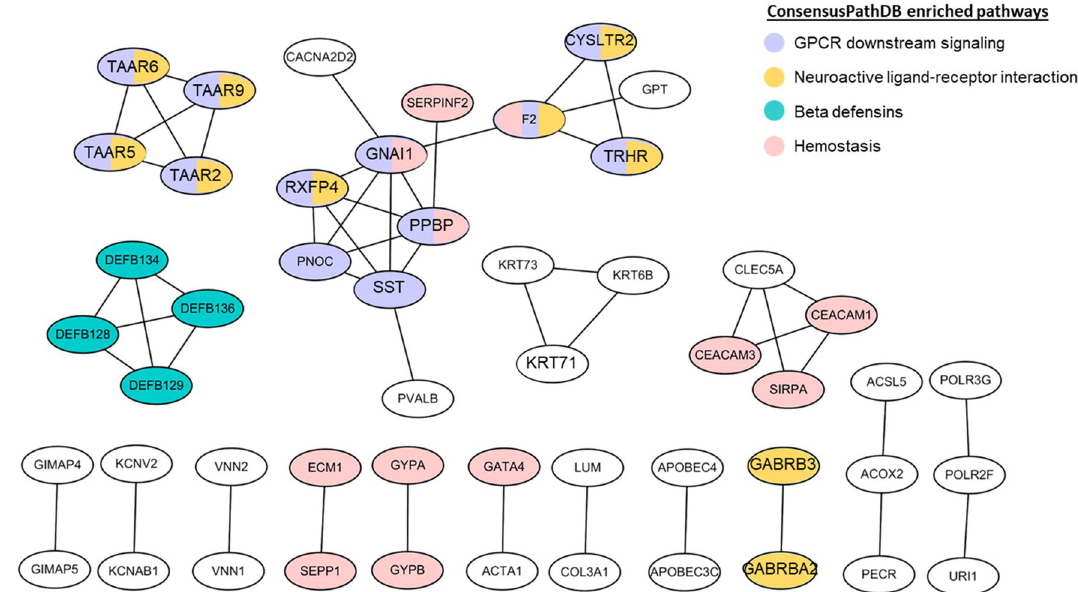
Figure 3. Protein–protein interaction network of 901 genes with differential methylation in 18LOH group. STRING Database with input of the 901 genes predicted protein–protein interactions which are either direct (physical) or indirect (functional). Genes that met the highest confidence for interaction (> 0.9) are shown in the Fig. (51 genes). Lines connect genes that were predicted for interacting. Overlay of pathways that are overrepresented in the set of 901 genes, identified four pathways in this subset of 51 genes. Genes assigned to the pathway are indicated as follows: GPCR signaling (purple); Neuroactive ligand-receptor interaction (yellow); Beta-defensins (green) and Hemostasis (pink). For genes assigned to multiple pathways, the circle is multiple